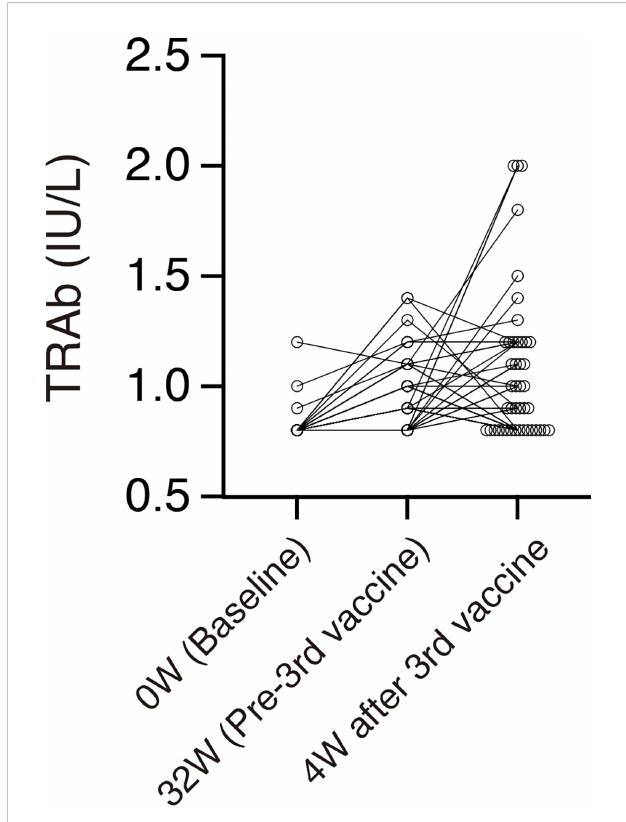
FIGURE 3 Time courses of TRAb in individuals whose TRAb is more than the lower limit of the range (0.8 IU/L) at any time point. Each circle denotes an individual value. n = 44.